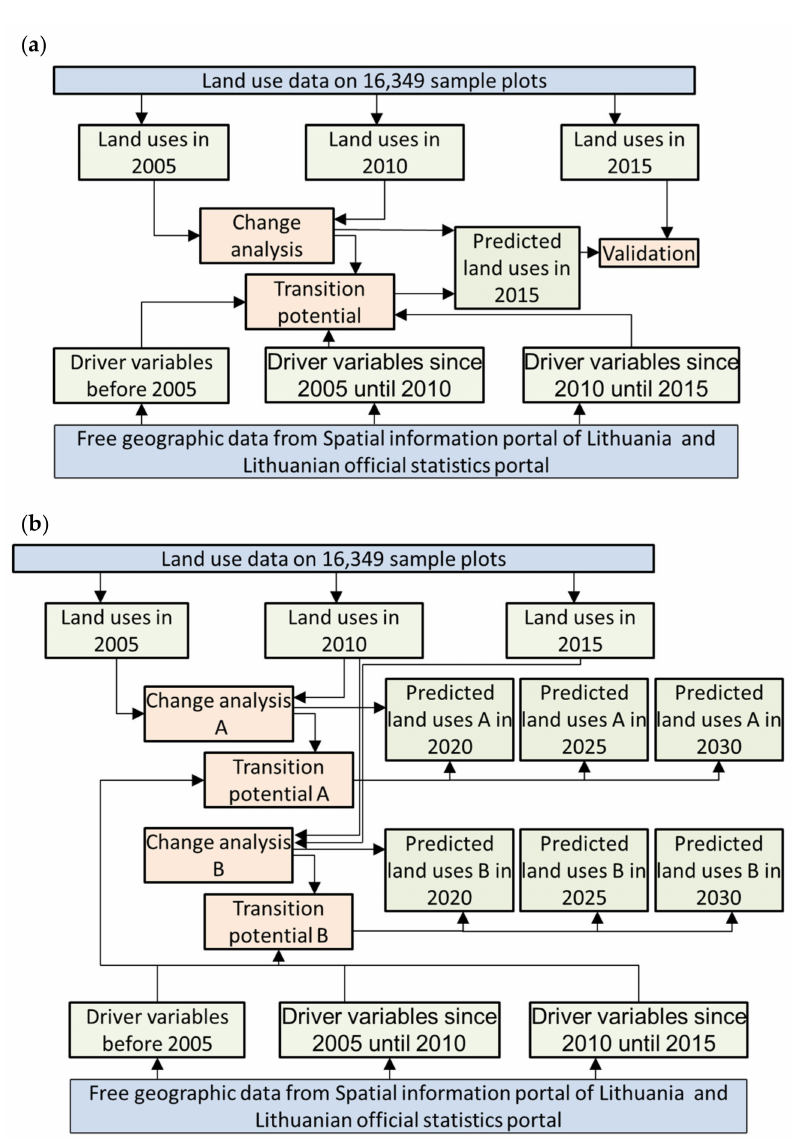
Figure 3. Flowchart summarizing the overall structure of the study: ( a ) calibrating and validating the land use change model, and ( b ) modeling land use development until